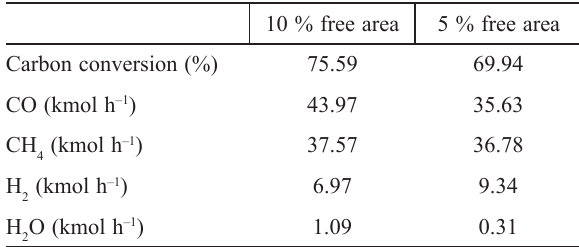
Table 4 – Effect of distributor free area on product composi-